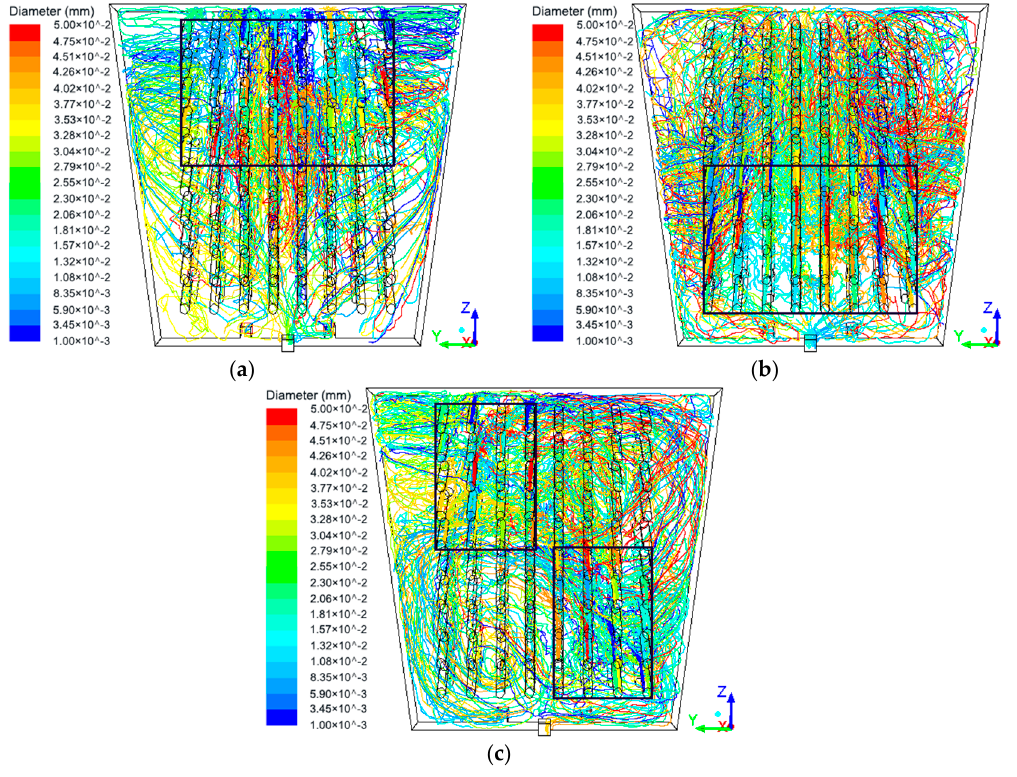
Figure 8. Trajectories of the inclusions between the baffles in the tundish with MHDB in different hole array modes. ( a ) UILO mode; ( b ) LIUO mode; ( c ) X mode. array modes. ( a ) UILO mode; ( b ) LIUO mode; ( c ) X